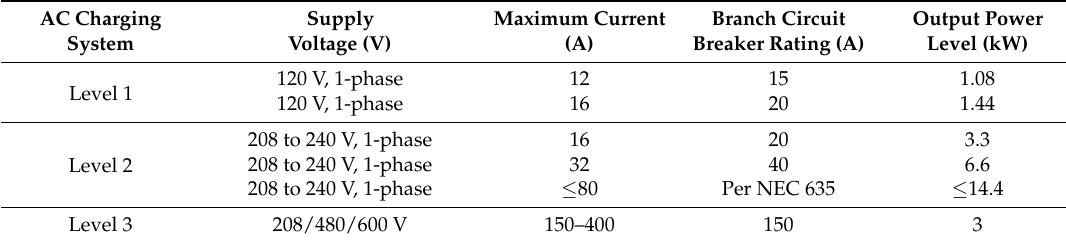
Table 19. SAE (Society of Automotive Engineers) AC charging characteristics. Data from